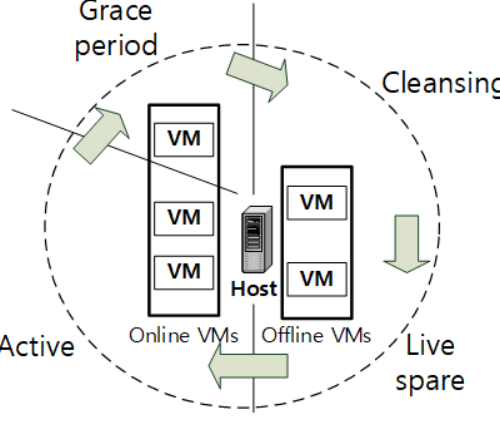
Figure 1. Overview of a self-cleansing intrusion tolerance (SCIT) system. VM: virtual